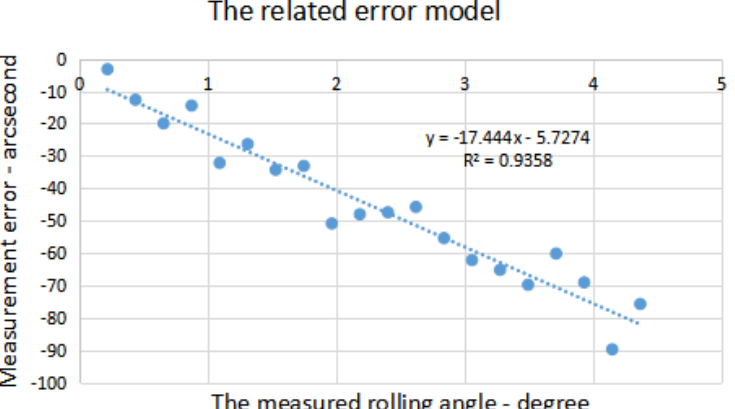
Figure 27. The related linear error model.